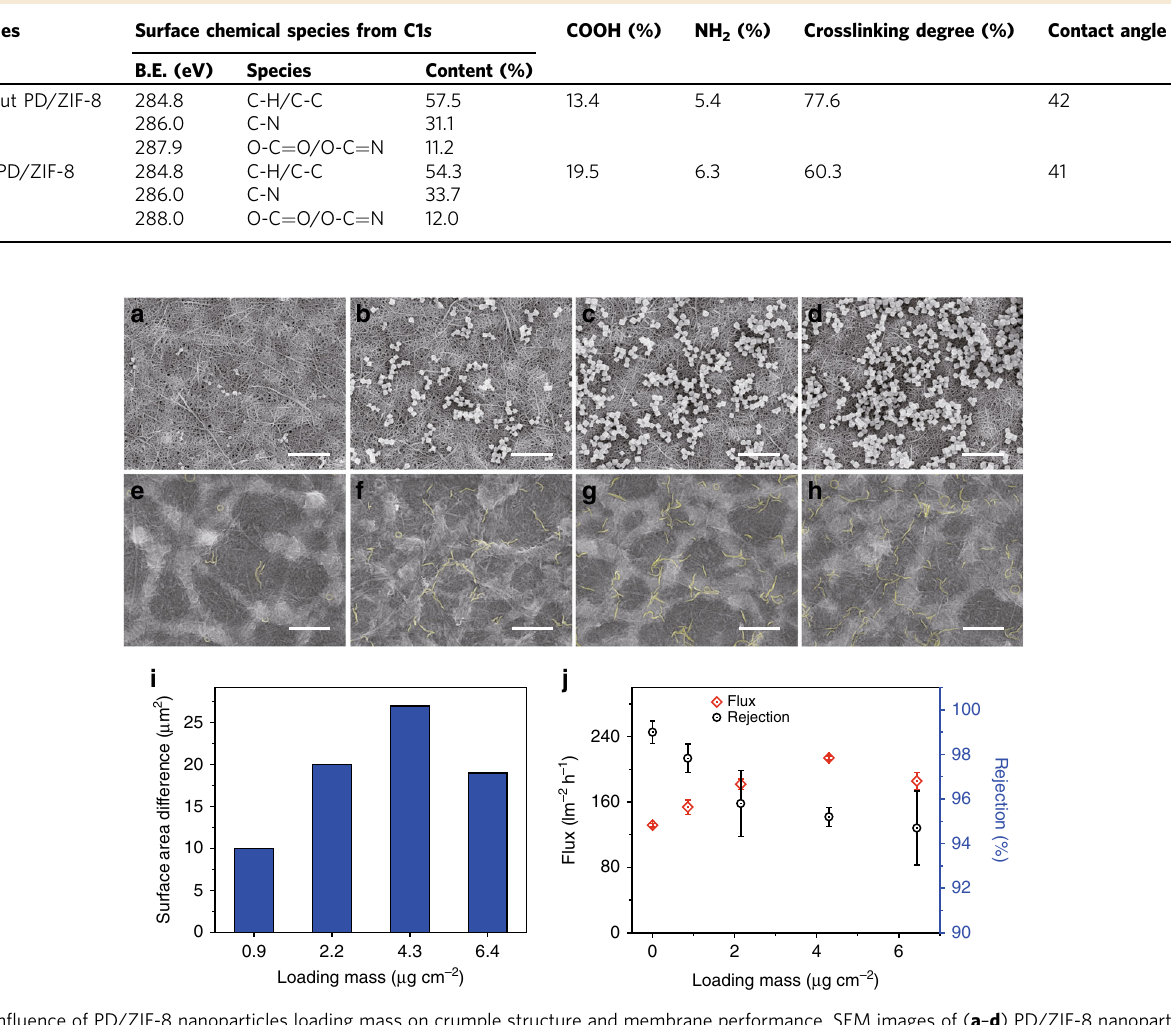
Fig. 3 In fl uence of PD/ZIF-8 nanoparticles loading mass on crumple structure and membrane performance. SEM images of ( a – d ) PD/ZIF-8 nanoparticles loaded SWCNTs/PES composite membrane (scale bar: 1 μ m) and ( e – h ) corresponding PA NF membranes with different PD/ZIF-8 nanoparticles loading